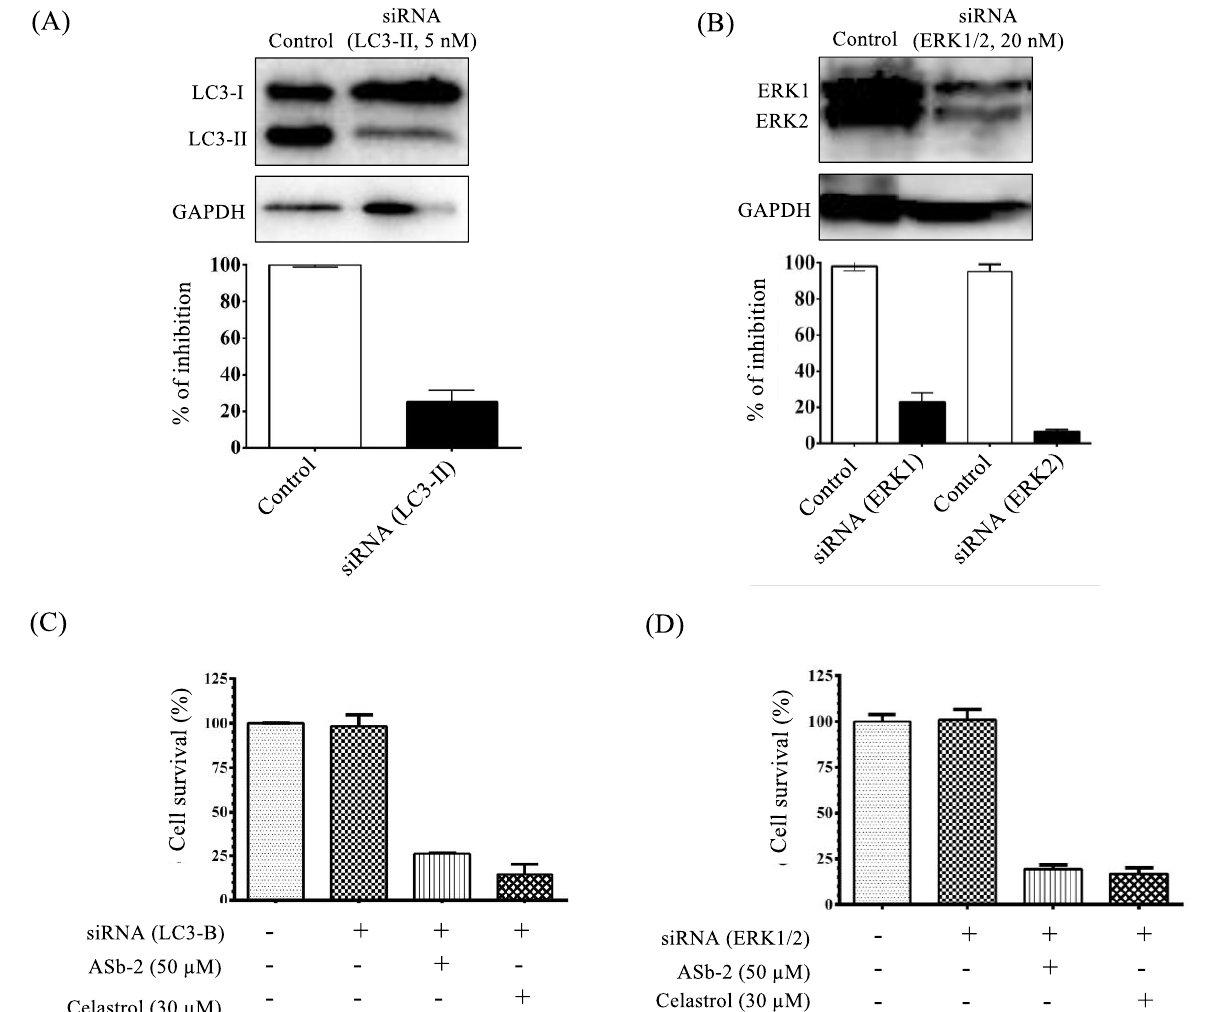
Figure 15. ( A ) Western blot results of LC3-II knock-down by siRNA-LC3-II (5 nM) in Jurkat cells. ( B ) Western blot results of ERK1/2 knock-down by siRNA-ERK1/2 (20 nM) in Jurkat cells. ( C ) The results of MTT assays of Jurkat cells treated with siRNA (LC3-II), ASb-2, and celastrol. ( D ) The results of MTT assays of Jurkat cells treated with siRNA (ERK1/2), ASb-2, and celastrol.